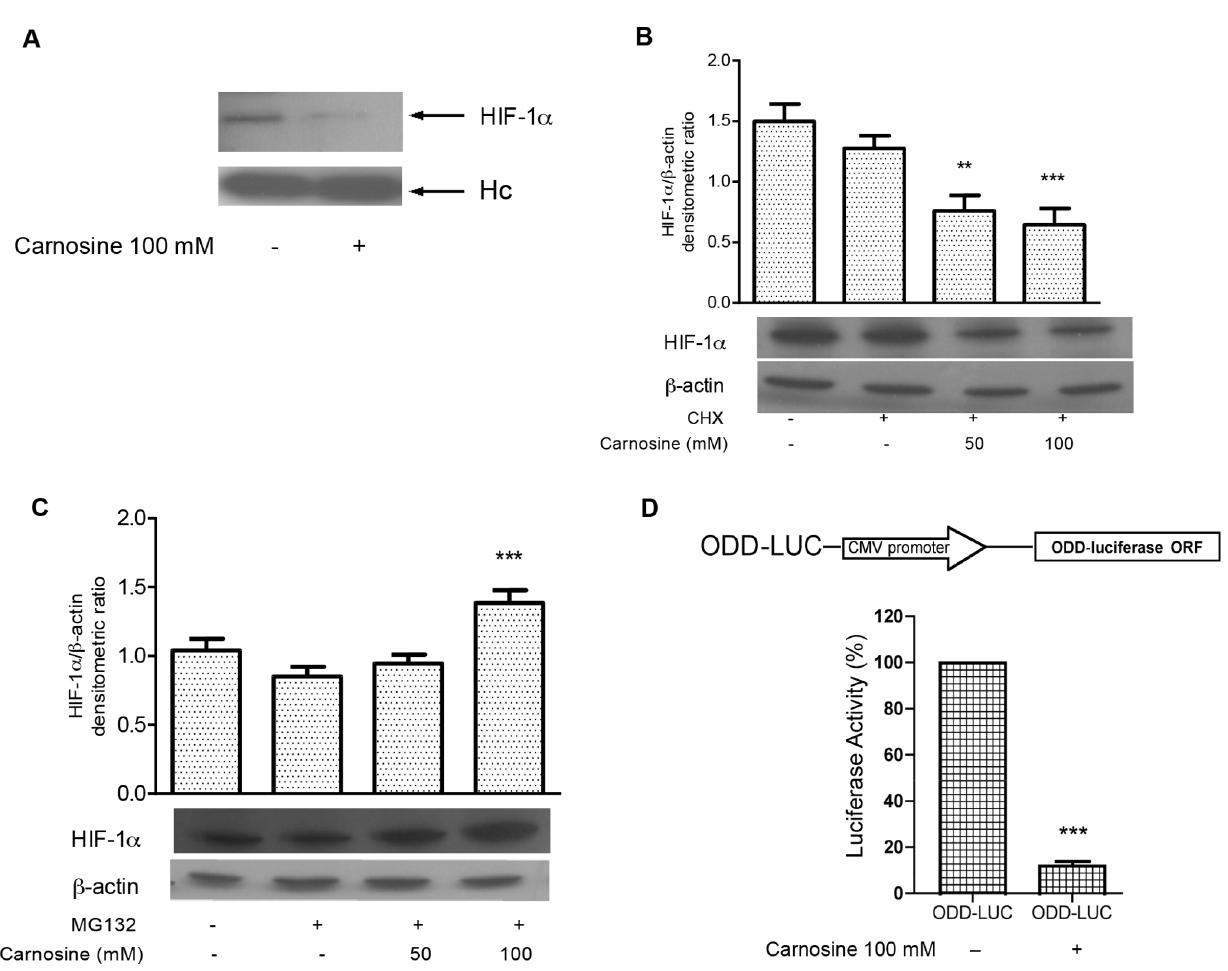
Figure 2. L-carnosine reduces the HIF-1 a protein level affecting its stability and induces HIF-1 a proteasome-dependent degradation. (A) Western blotting analysis probed with anti-HIF-1 a antibody of immunoprecipitated proteins in HCT-116; (B) western blotting analysis of total protein extracts from HCT-116 cells 24 h after L-carnosine (100 mM) or L-carnosine (100 mM) plus 10 mM cycloheximide (CHX) treatment probed with HIF-1 a and b -actin antibodies. Related histograms report the densitometric values of HIF-1 a / b -actin ratio; (C) western blotting analysis of total protein extracts from HCT-116 cells 24 h after L-carnosine (100 mM) or L-carnosine (100 mM) plus 1 mM MG132 treatment probed with HIF-1 a and b -actin antibodies. The densitometric values represent the mean 6 SDs of three independent experiments. The differences were considered significant at **p , 0.001, ***p , 0.0001; (D) Schematic representation of ODD-LUC reporter vector. ODD-LUC vector contains the oxygen- dependent degradation (ODD) domain of HIF-1 a cloned upstream from the luciferase gene. The luciferase activity was measured 48 h after transfection and represents the mean 6 SDs of three independent experiments. The values have been reported as percentages of luciferase activity compared to 100% of untreated